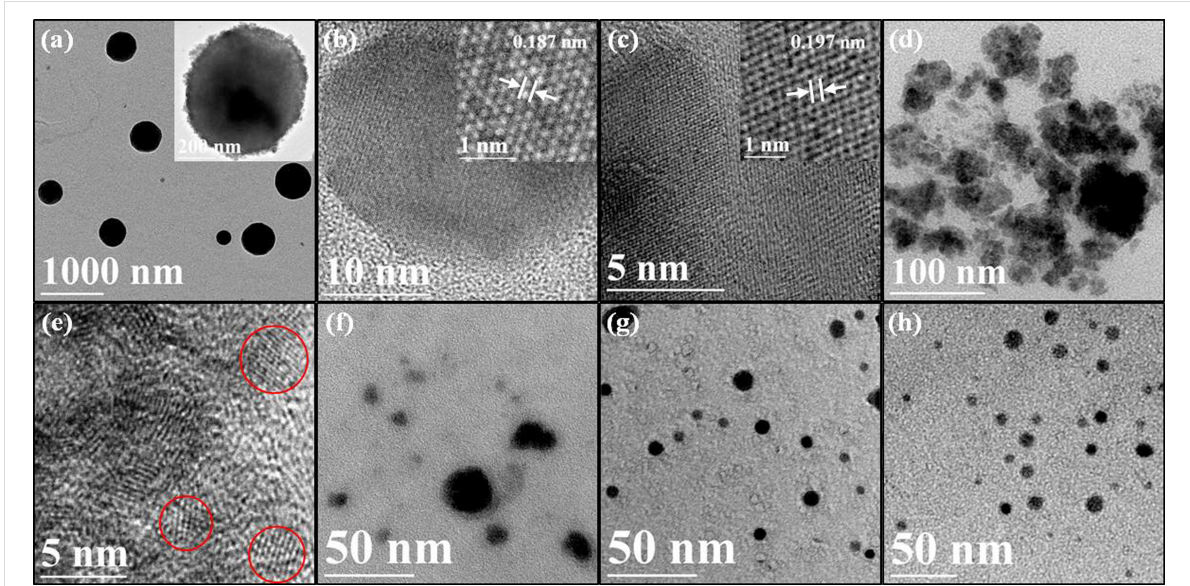
Figure 6: TEM images of (a, b, c) Cu 7 S 4 and Cu 1.8 S nanocrystals collected prior to hydrothermal reaction and CZTS nanocrystals synthesized at different reaction duration: (d, e) 0.5 h, (f) 2 h, (g) 8 h, and (h) 24 h